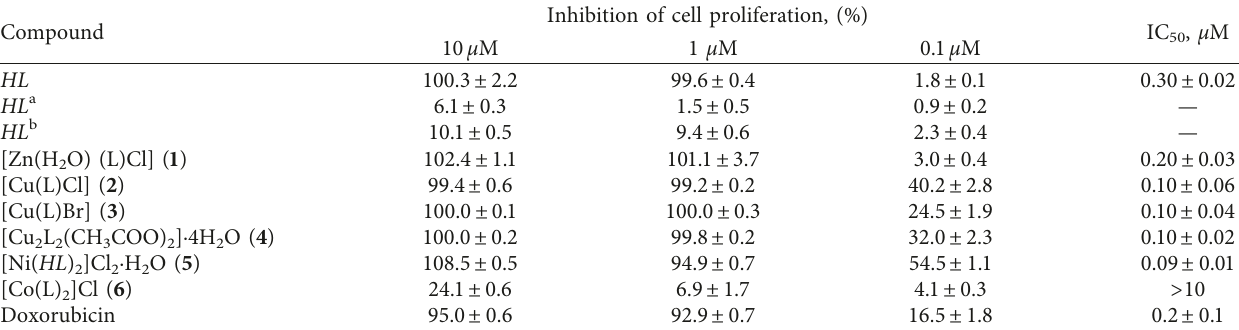
Table 3: Antiproliferative activities of some synthesized compounds on human leukemia HL-60 cell line at three concentrations. Inhibition of cell proliferation, Compound